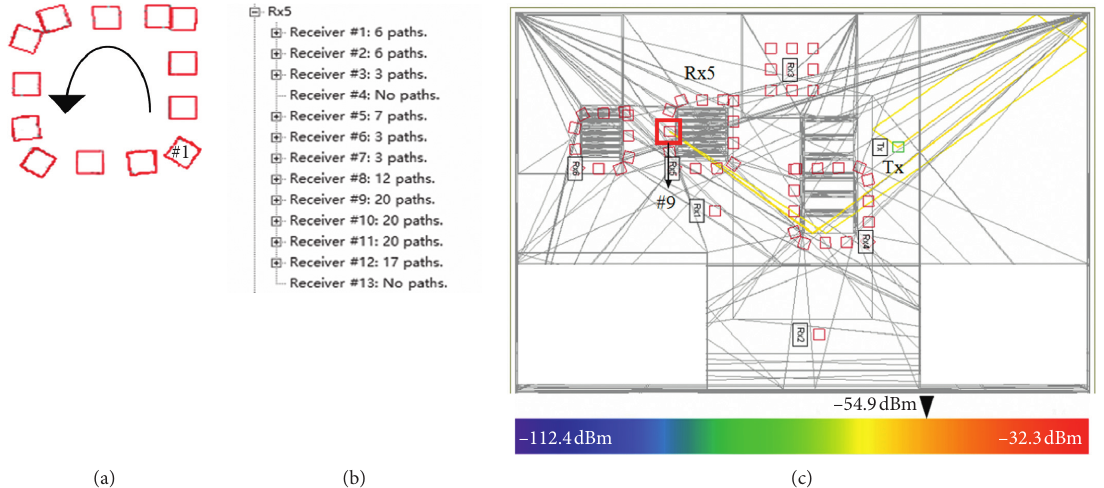
Figure 7: Simulated results of the Rx5 receiver. (a) Node deployment of Rx5. (b) Effective reception path situation of Rx5. (c) A few transmission paths of the #9 node